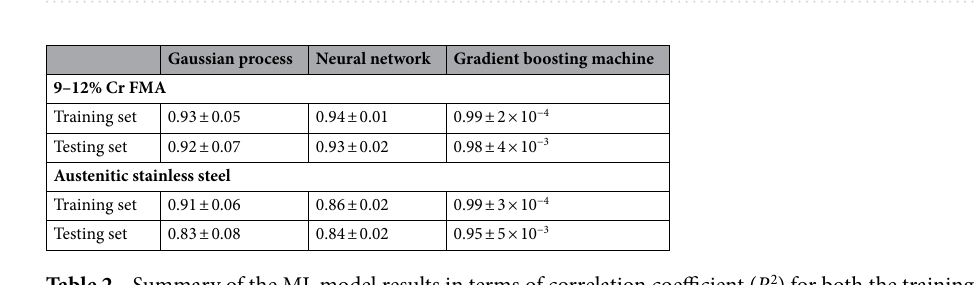
Figure 2. Parity plot for the testing data for GP regression for the 9–12% Cr FMA (left) and austenitic stainless steels (right).